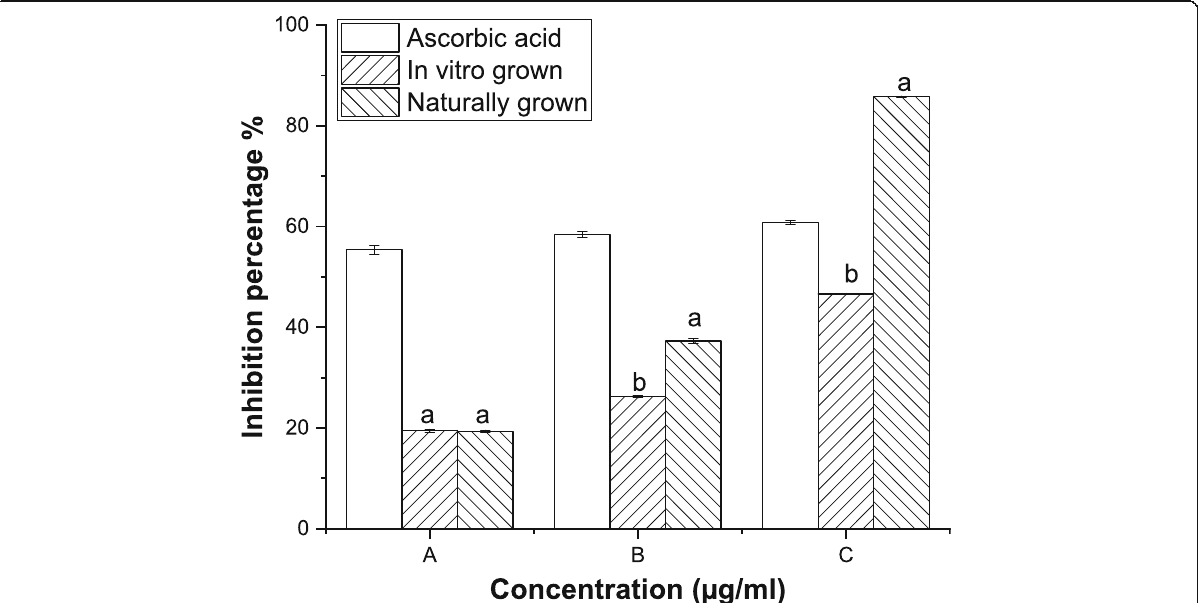
Fig. 4 Metal chelating activity of in vitro and naturally grown L. cruciata with their comparison with standard Ascorbic acid . Values with different letters (a, b) are significantly ( p < 0.05) different from each other by Turkey ’ s multiple range